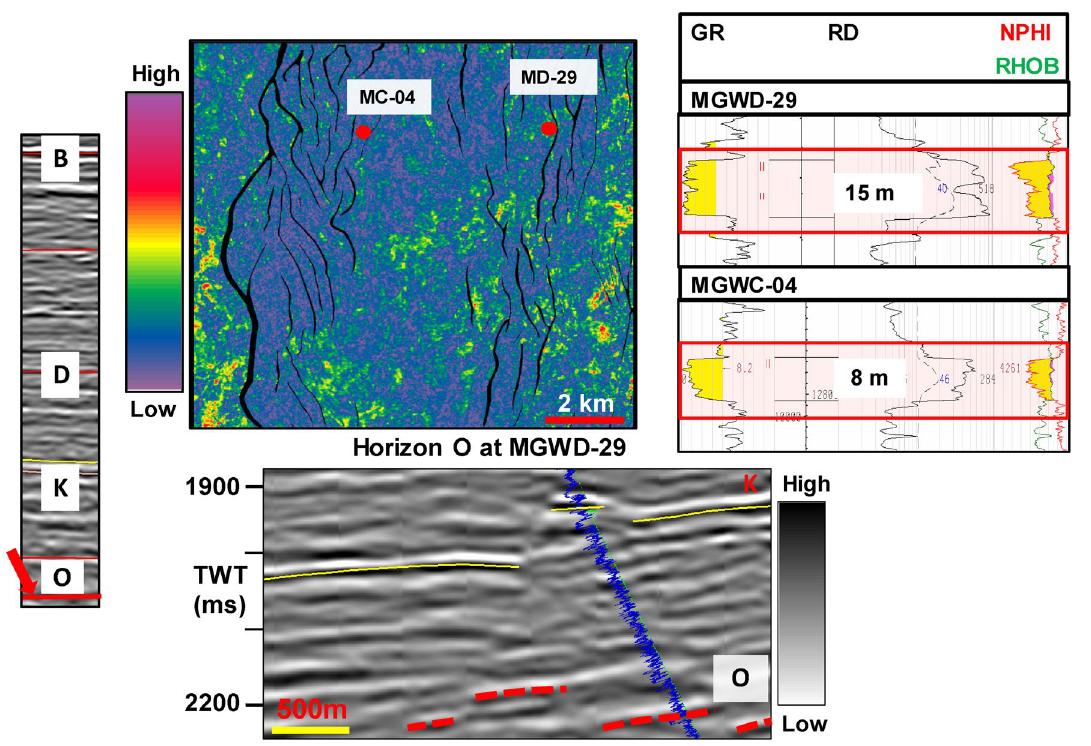
Fig. 6 The RMS amplitude map of O horizon. The high amplitudes show sporadic pattern. High amplitudes have been noticed for 15 m thick sand at well MGWD-29, whereas no high amplitude anomaly